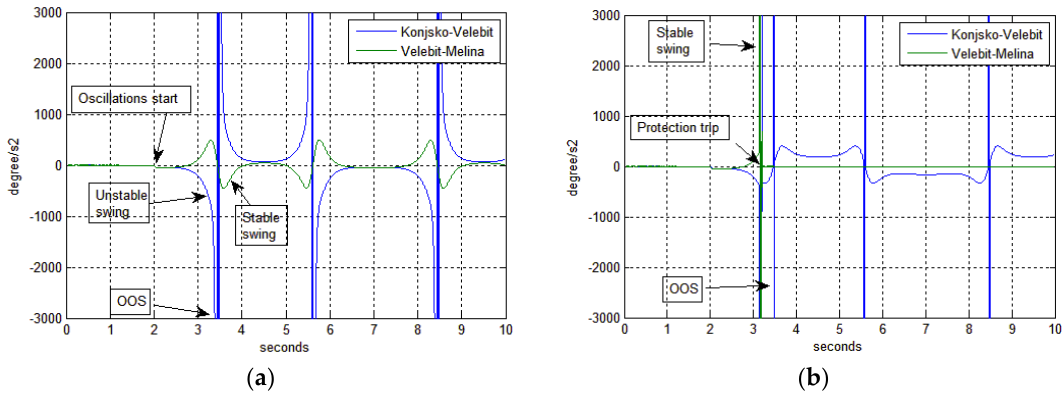
Figure 16. Active power oscillations on two 400 kV lines with angle acceleration α : ( a ) On line Konjsko-Velebit there is an out-of-step (OOS) condition and on line Velebit-Melina there is a power swing condition; and, ( b ) Detail presenting angle speed ω protection operation and tripping of the the Konjsko-Velebit line while Velebit-Melina remained in operation. Konjsko-Velebit line while Velebit-Melina remained in operation.